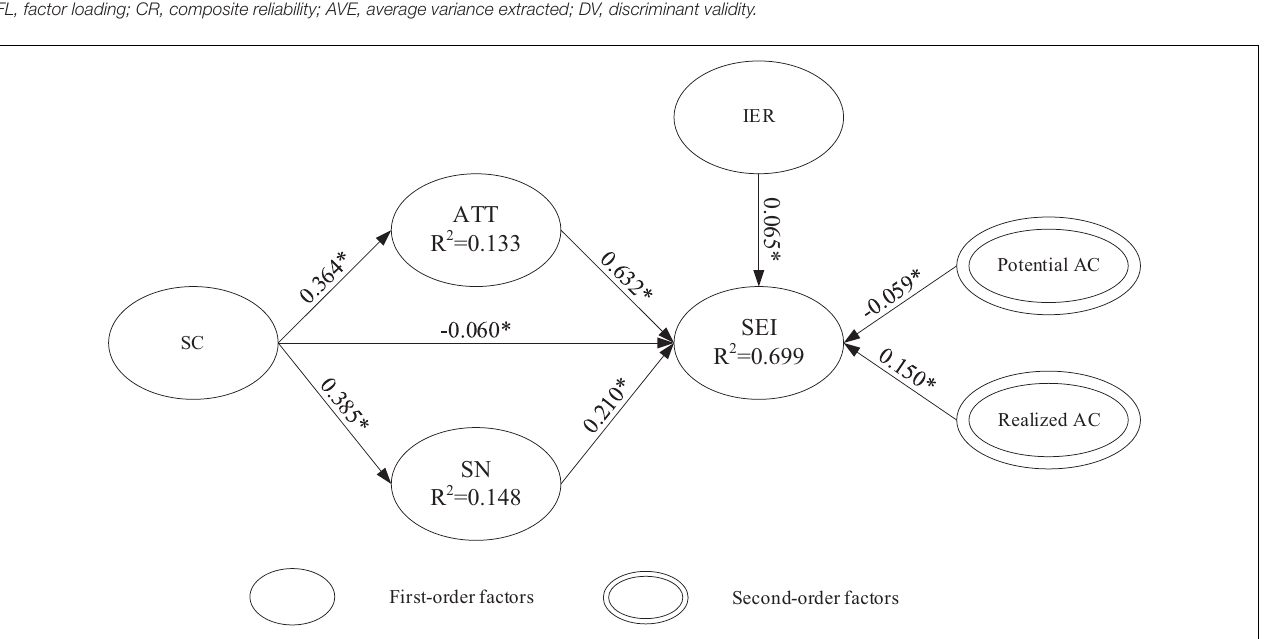
(CI) of 95%]. The mediation path, coefficient, t -value, and CI are